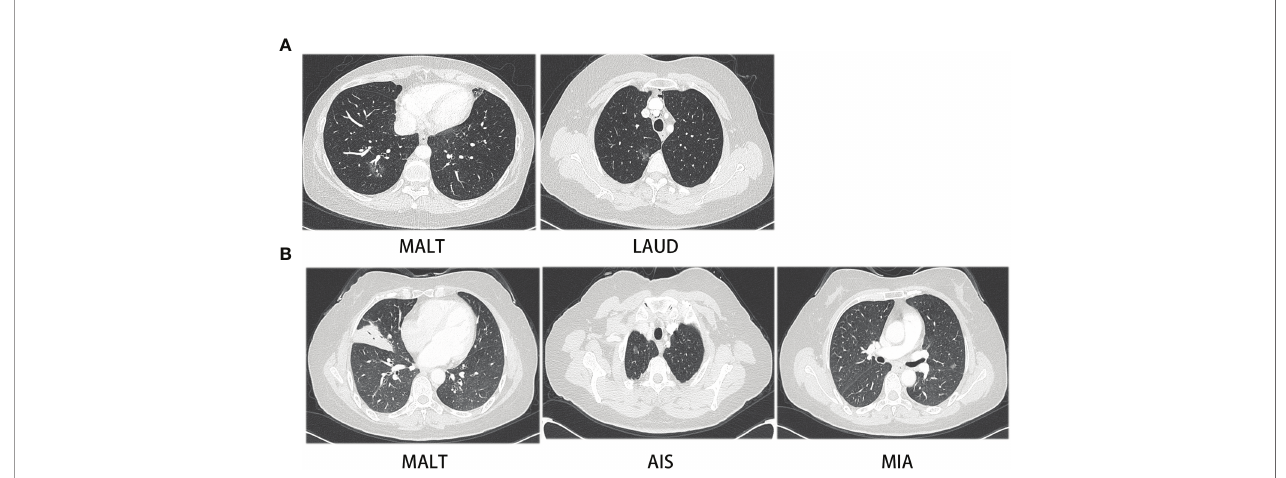
FIGURE 4 | CT images of two patients with synchronous PPL and NSCLC. (A) CT images of patient with MALT and LAUD, (B) CT images of patient with MALT, AIS and